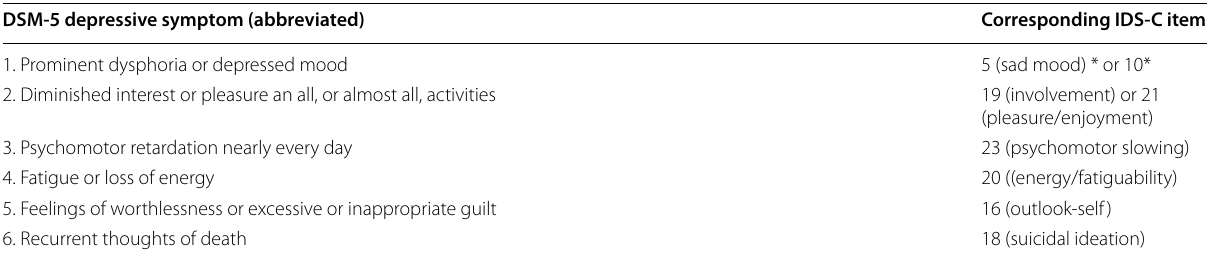
*A minimum score of 2 is needed to satisfy criterion